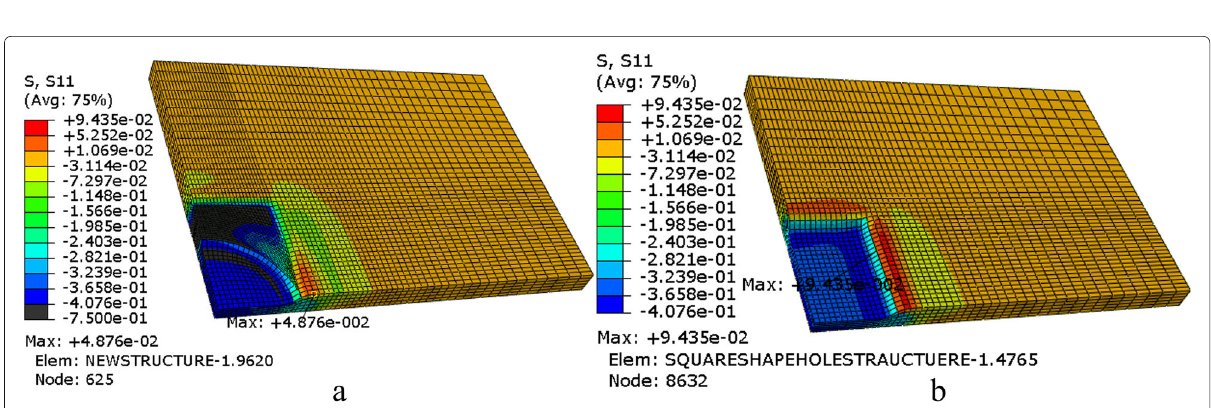
Fig. 7 Maximum principal stress of the surface layer with circular repairs ( a ) and rectangular repairs ( b